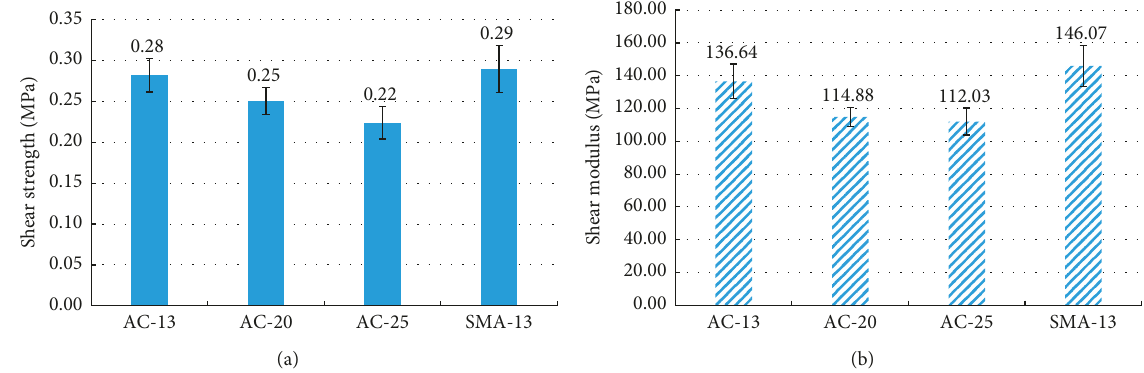
Figure 11: (a) Shear strength and (b) shear modulus of asphalt